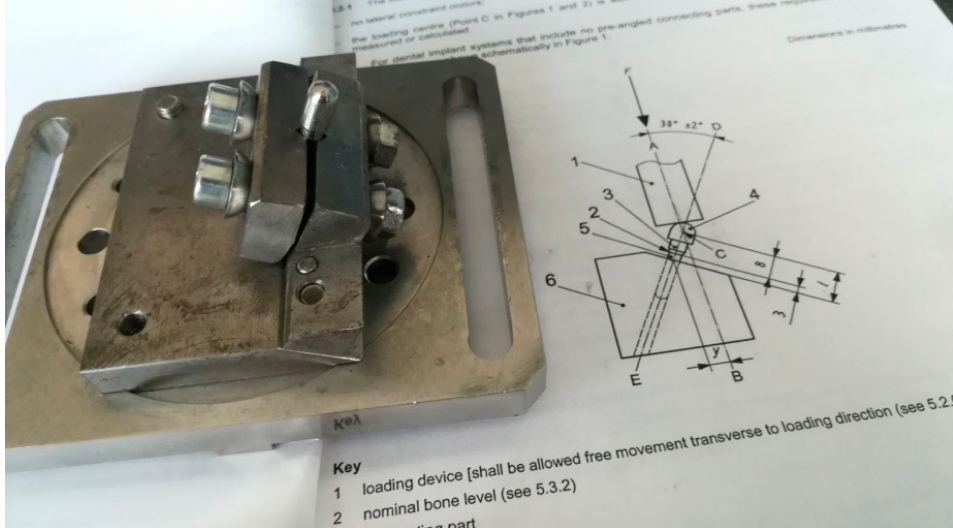
Figure 7. Implant positioned for the second round of mechanical (dynamic) testing. This protocol eliminated the bone blocks present in the first tests. The implants were fitted directly into the testing machine’s vise.